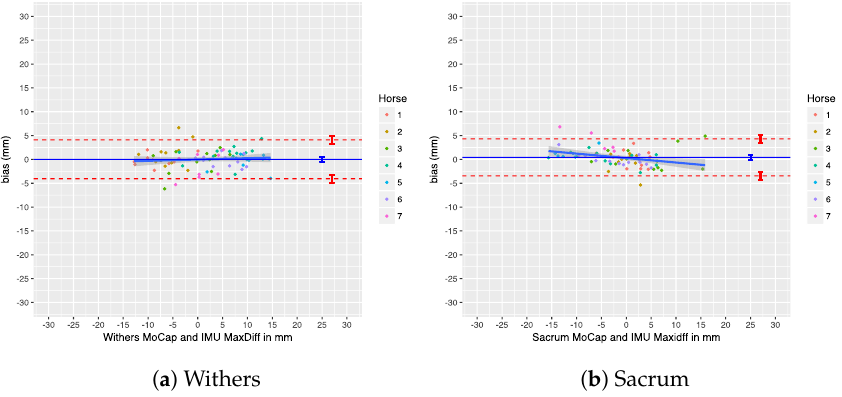
Figure 28. Bland–Altman analysis for Max_diff parameter. Table 8. Summary of measurement agreement statistics for the withers (values in mm).